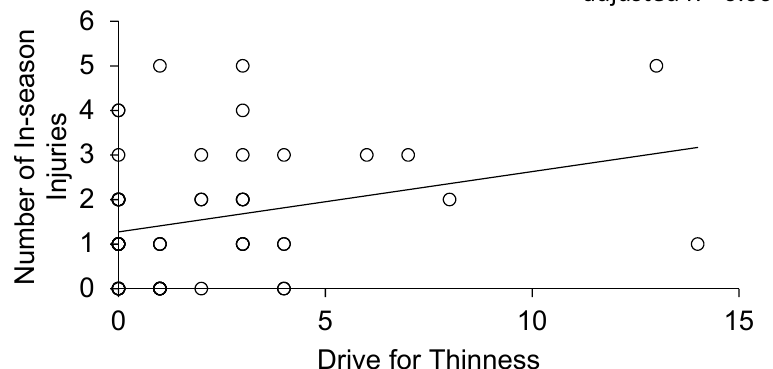
Figure 2. The correlation between the drive for thinness score and in-season musculoskeletal injuries in NCAA division II athletes ( p = 0.034).